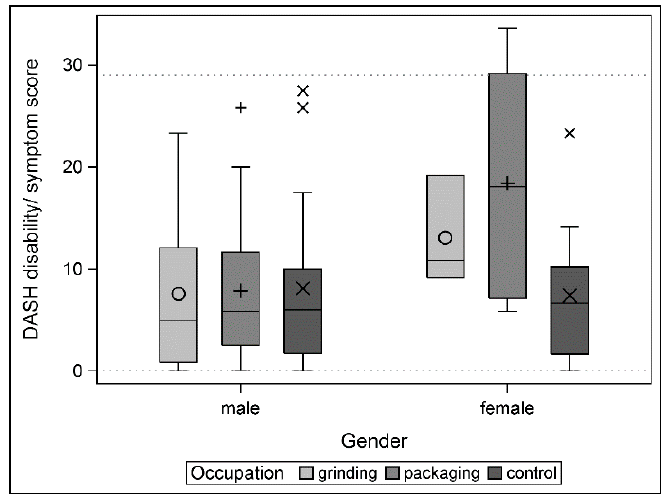
Figure 5. Distribution of the DASH disability/symptom score by gender.